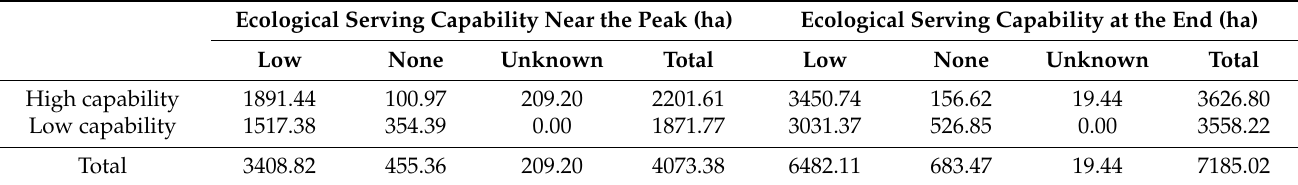
Table 2. The landcover conversion matrix showing the degradation of land ecological serving capability near the peak and at the end of the boom in the Muskingum River Watershed due to unconventional shale gas extraction activities. Ecological Serving Capability Near the Peak (ha)